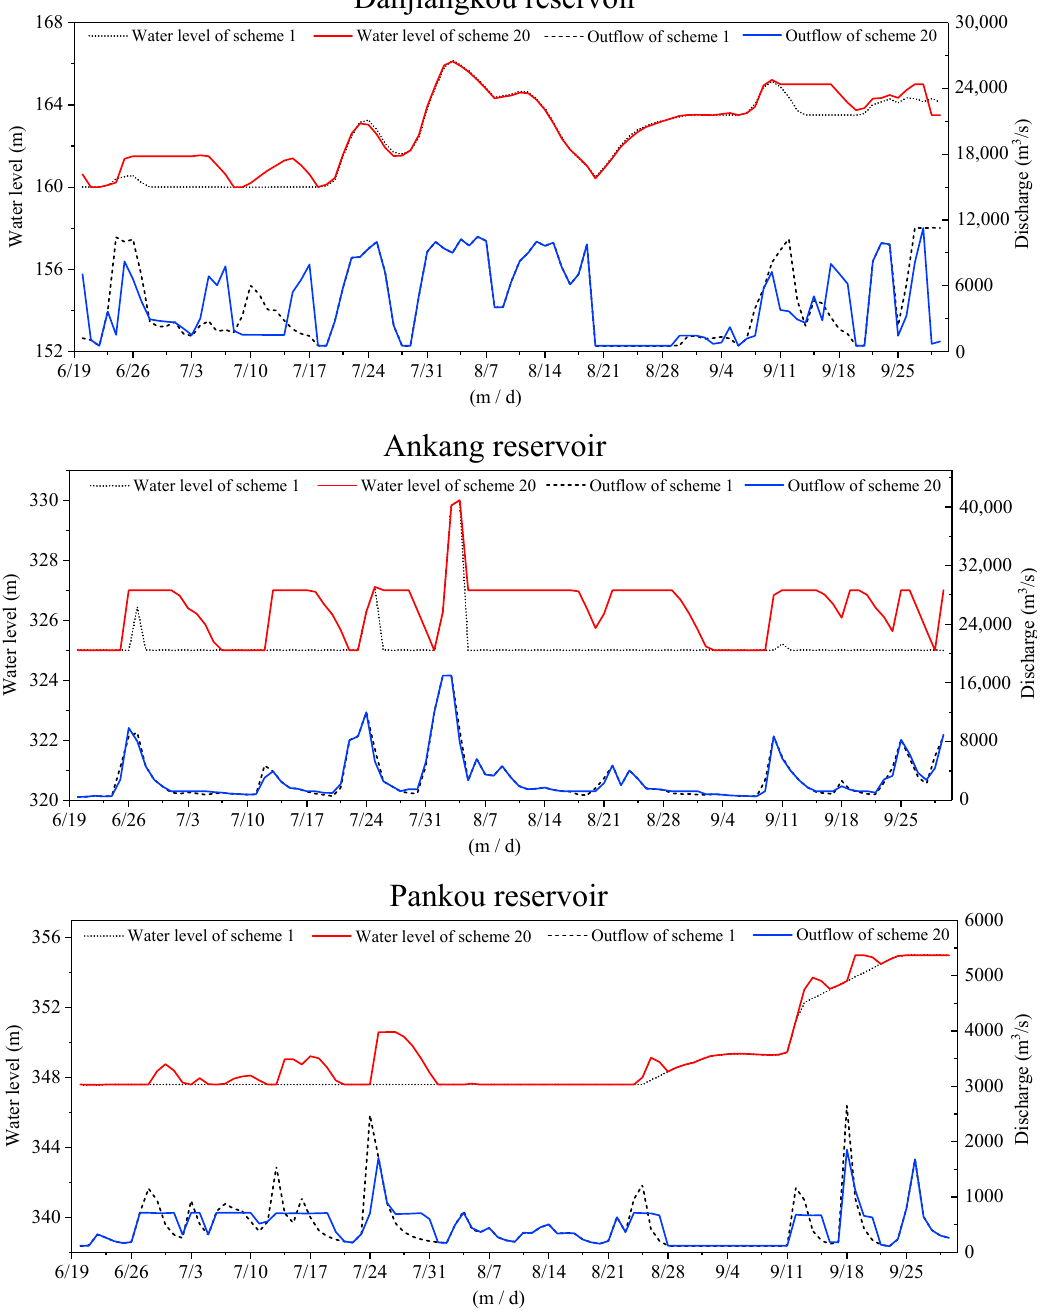
Figure 4. Comparison of operation process between scheme 1 and scheme 20 in a wet year. By comparing scheme 1 and scheme 20, the FLWL dynamic control method in this paper is more suitable for the normal year where small and medium floods occur frequently, because the flood level of the normal year is not large and is easier to use. In contrast, this method cannot work as well during a wet year in which big floods occur, because the floods last longer, the volume of floods is larger, and the utilization di ffi culty is high. For the dry year, the inflow is too small, so that the FLWL dynamic control method cannot play a